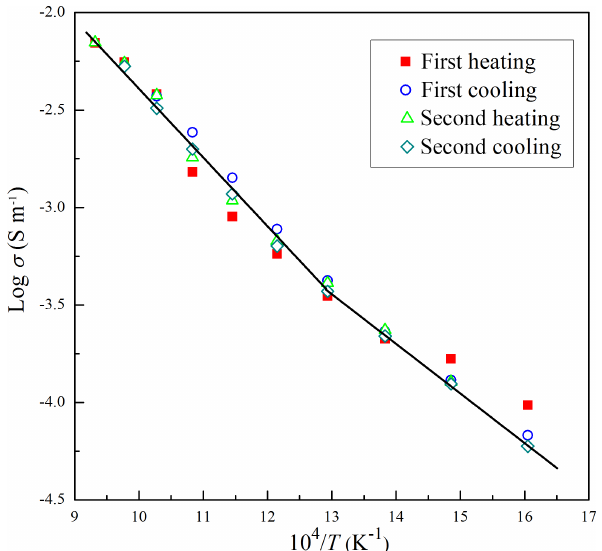
Figure 6. Logarithm of the electrical conductivities versus the re- ciprocal temperatures for run DS12 gneiss at 0.5–2.5GPa and 623– 1073 K.